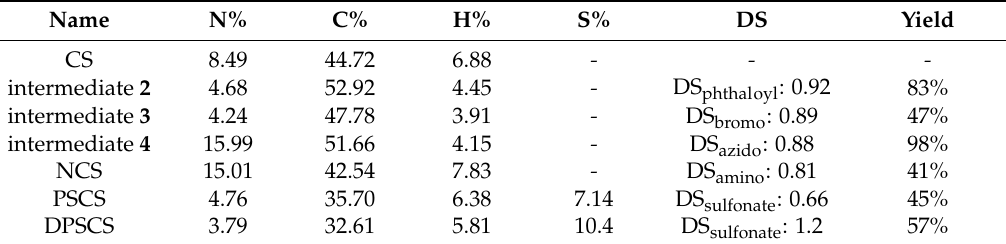
Table 1. The elemental analyses, yields, and the degrees of substitution of samples.